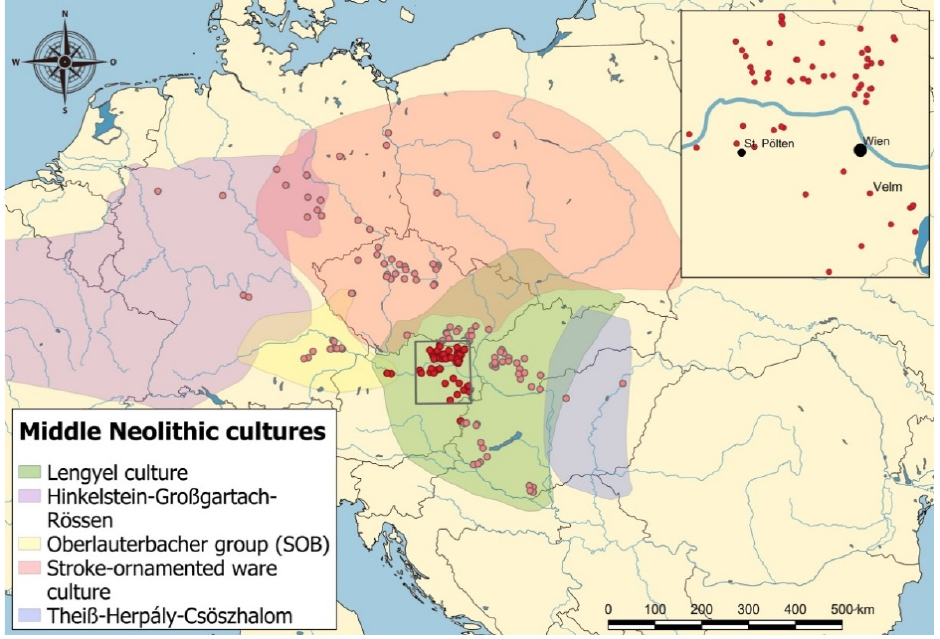
Figure 1. Distribution of the KGAs (signified by red dots) in Central Europe and the Austrian core area in relation to the archaeologically defined cultural groups (LBI ArchPro).